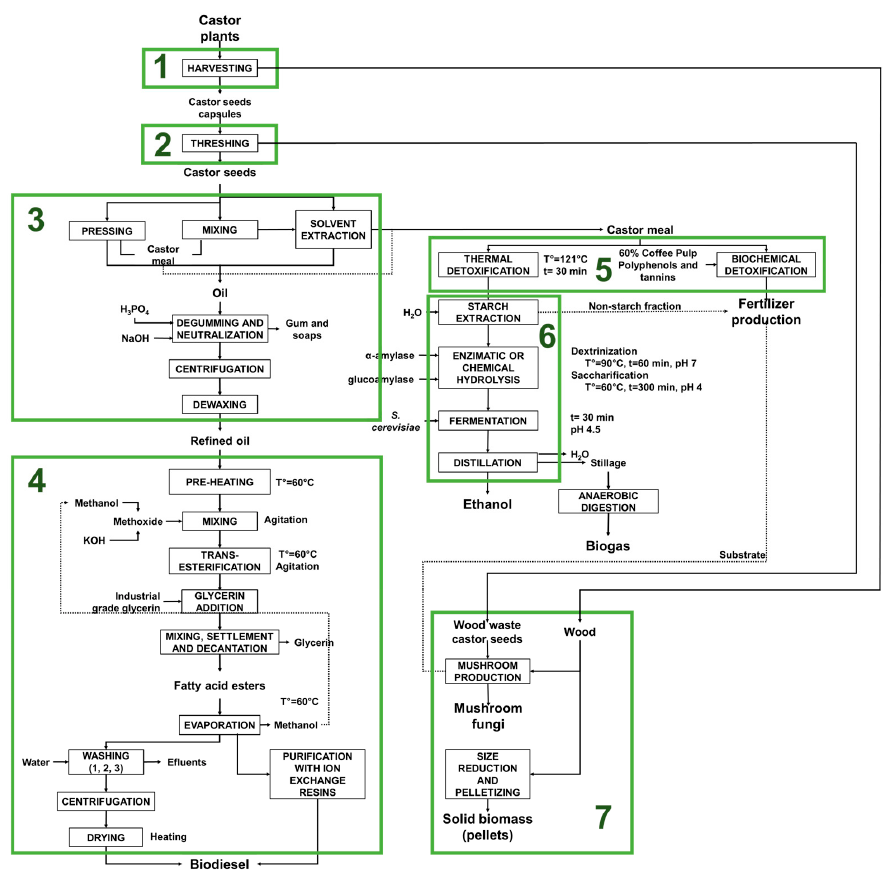
Figure 2. Proposal of exploitation of the species Ricinus communis for biodiesel and co-products. Block 1. Castor plants